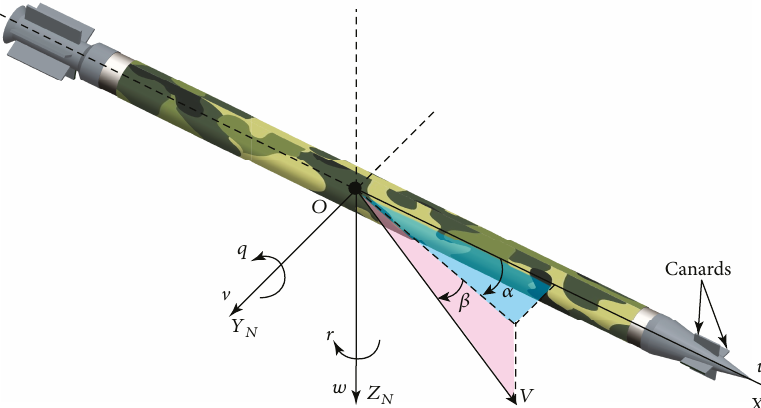
Figure 1: Sketch of guided spinning